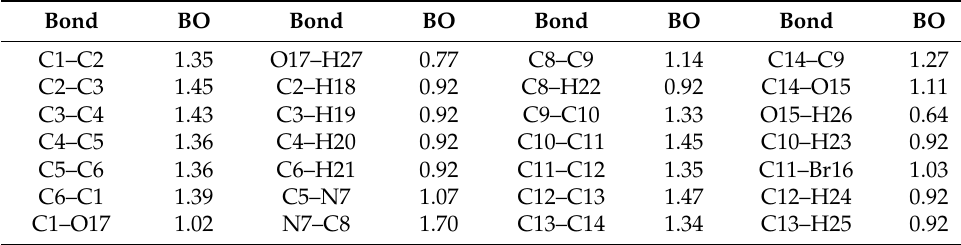
Table 7. Calculated bond orders, according to the Wiberg bond index a . Bond BO Bond